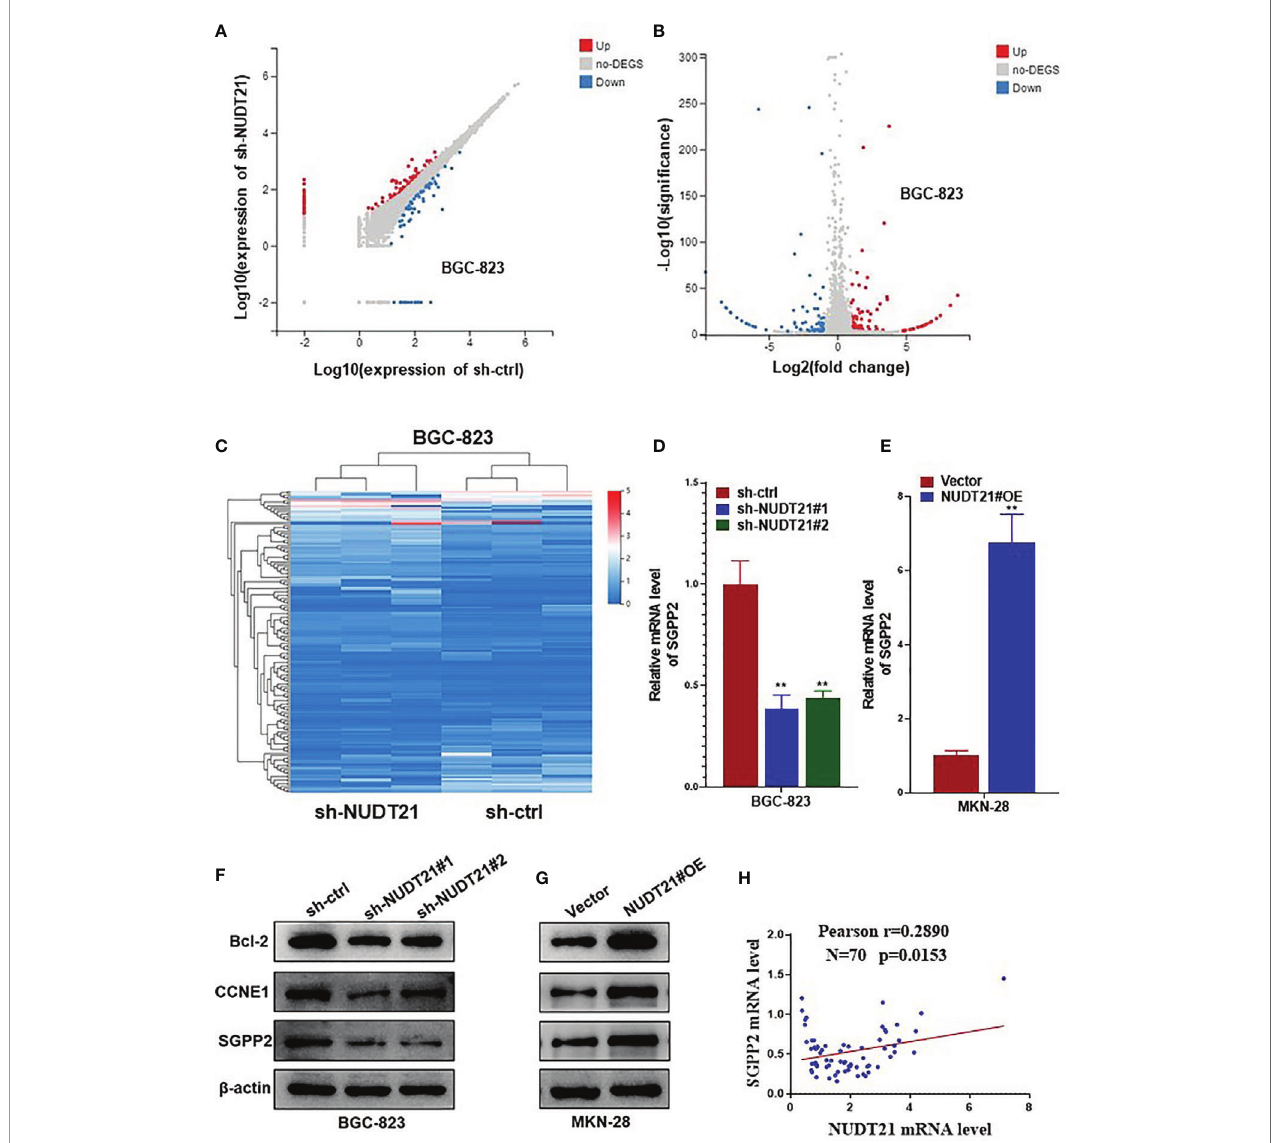
FIGURE 4 | NUDT21 regulated the expression of SGPP2 in gastric cancer cells. mRNA sequencing was performed in BGC-823-sh-NUDT21#1 and BGC-823-sh- ctrl cells. (A, B) Scatter plots showed the mRNAs with signi fi cant change between BGC-823-sh-NUDT21#1 and BGC-823-sh-ctrl cells. (C) Hierarchical clustering analysis. (D) mRNA levels of SGPP2 in BGC-823 cells after transfected with sh-NUDT21#1, sh-NUDT21#2 or sh-ctrl were examined by RT-qPCR. (E) mRNA levels of SGPP2 in MKN-28 cells after transfected with NUDT21#OE or Vector were examined by RT-qPCR. (F) Protein levels of Bcl-2, CCNE1 and SGPP2 in BGC-823 cells after transfected with sh-NUDT21#1, sh-NUDT21#2 or sh-ctrl were examined by western blot. (G) Protein levels of Bcl-2, CCNE1 and SGPP2 in MKN-28 cells after transfected with NUDT21#OE or Vector were examined by western blot. For RT-qPCR, GAPDH was used as control. For western blot, b -Actin was used as control. (H) The mRNA levels of NUDT21 and SGPP2 in the 70 gastric cancer tissues were examined by RT-qPCR, and the correlation between NUDT21 and SGPP2 expression was analyzed by Pearson correlation analysis. ** P <